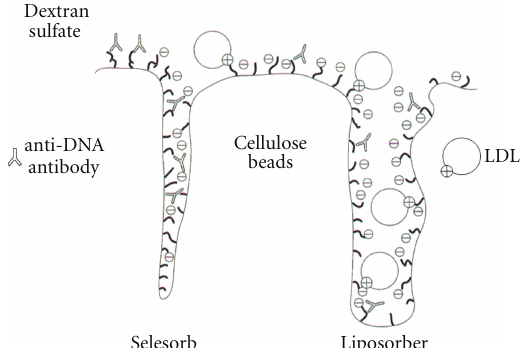
Figure 14: The di ff erence of between Liposorber and Selesorb. The pore size of Selesorb beads is smaller than that of Liposorber so that causative antibodies including anti-DNA antibody are selectively adsorbed avoiding larger-size molecules such as